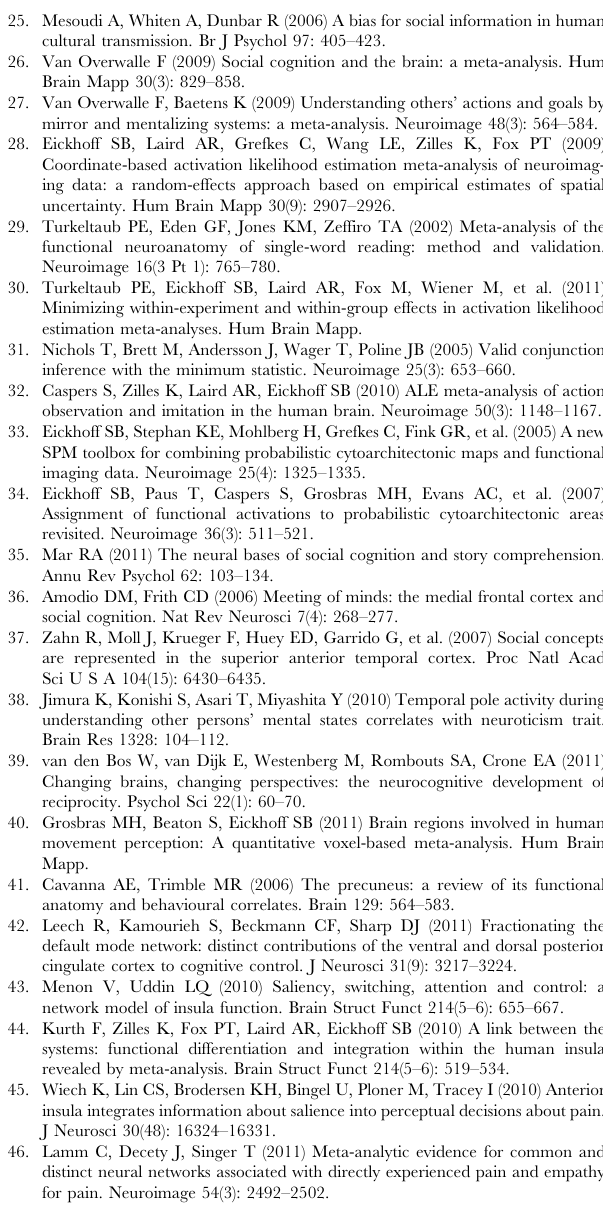
Macroanatomical